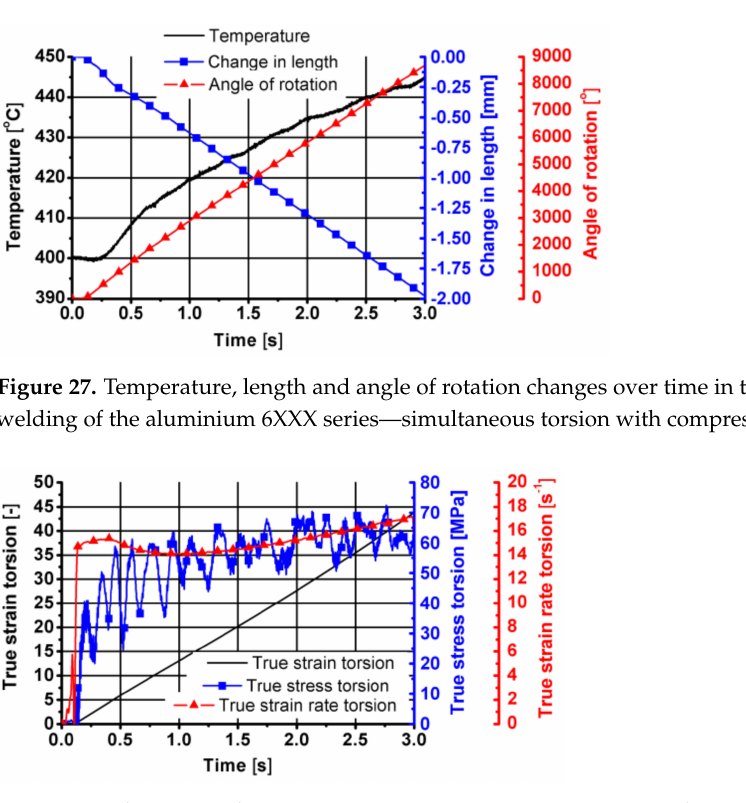
Figure 28. Changes in the true strain torsion, true stress torsion and true strain rate torsion over time in the first stage of friction welding of the 6XXX series aluminium—simultaneous torsion with compression components resulting from